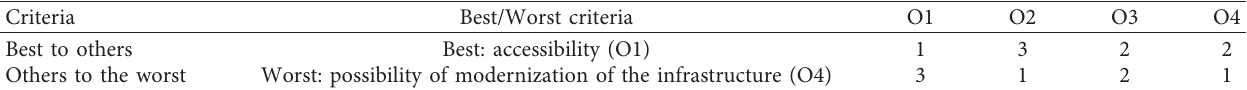
Table 8: External opportunities (EO)-pairwise comparison vector.